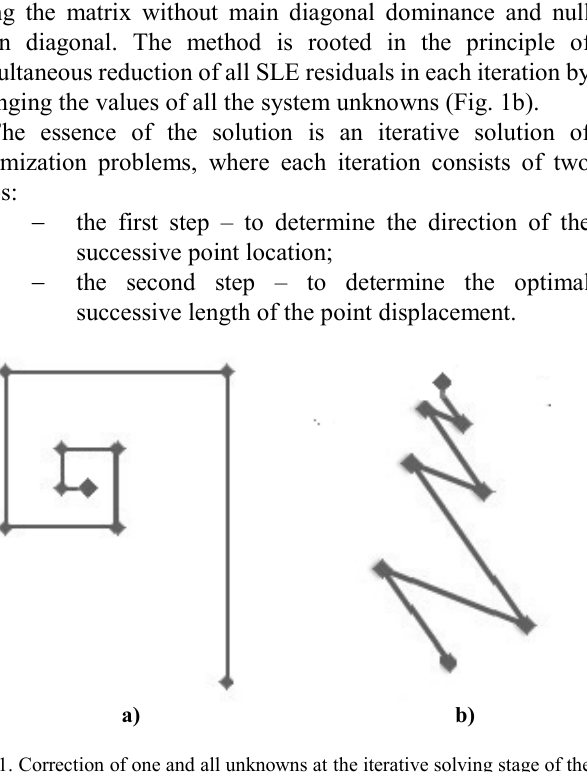
Fig. 1. Correction of one and all unknowns at the iterative solving stage of the equation system. First, the solution for a two-equation system will be dimensional